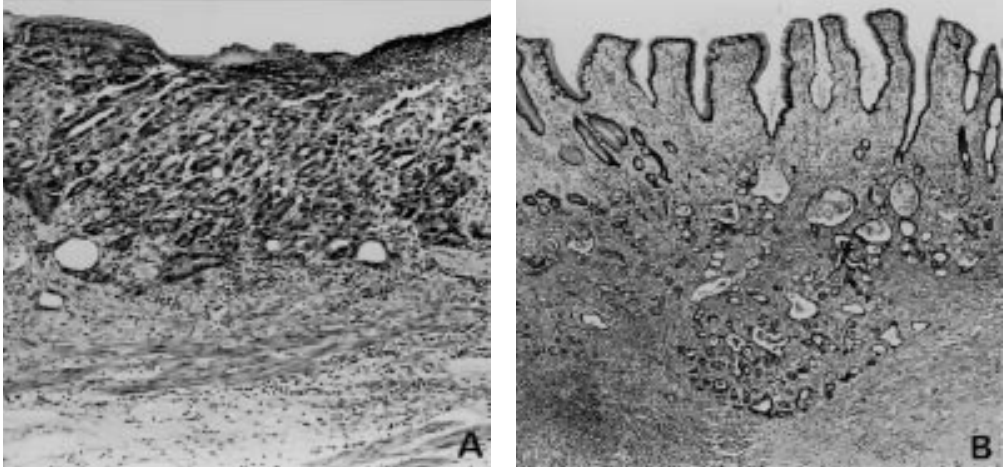
Fig. 3. View of a histological section cut through an area of intramucosal EGC (A) (HE, (cid:2) 150) and through an area of infiltrating submucosa EGC (B) (HE, (cid:2) 80).